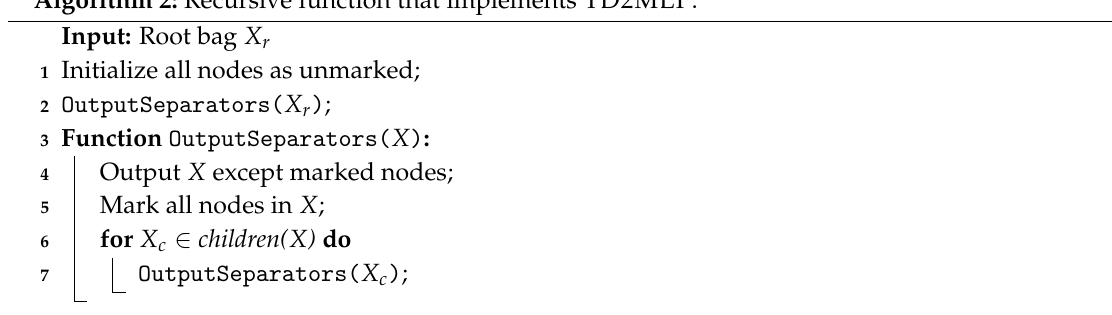
Algorithm 2: Recursive function that implements